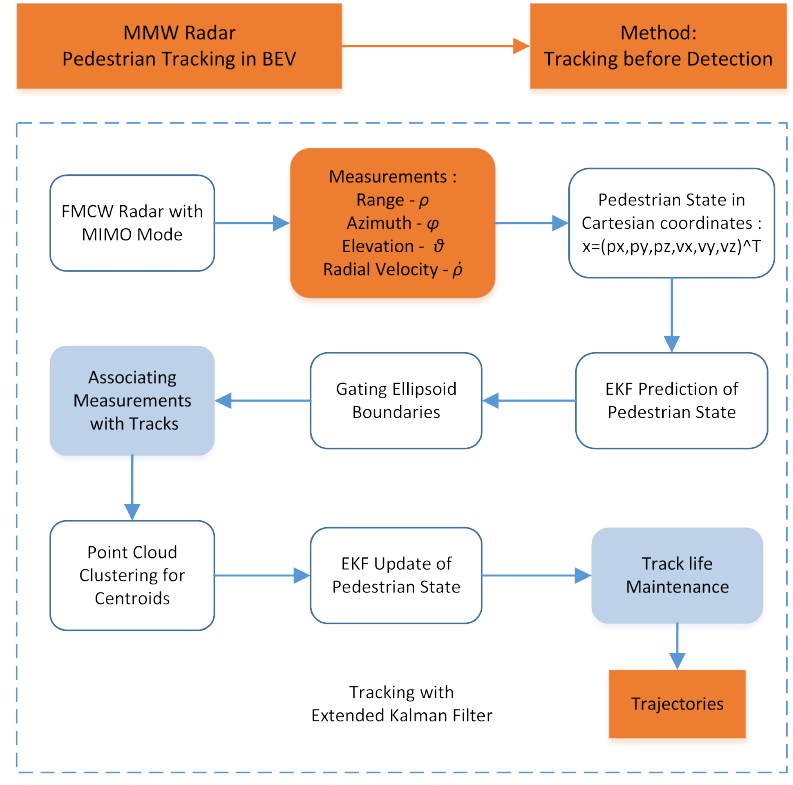
Figure 1. MMW radar pedestrian tracking